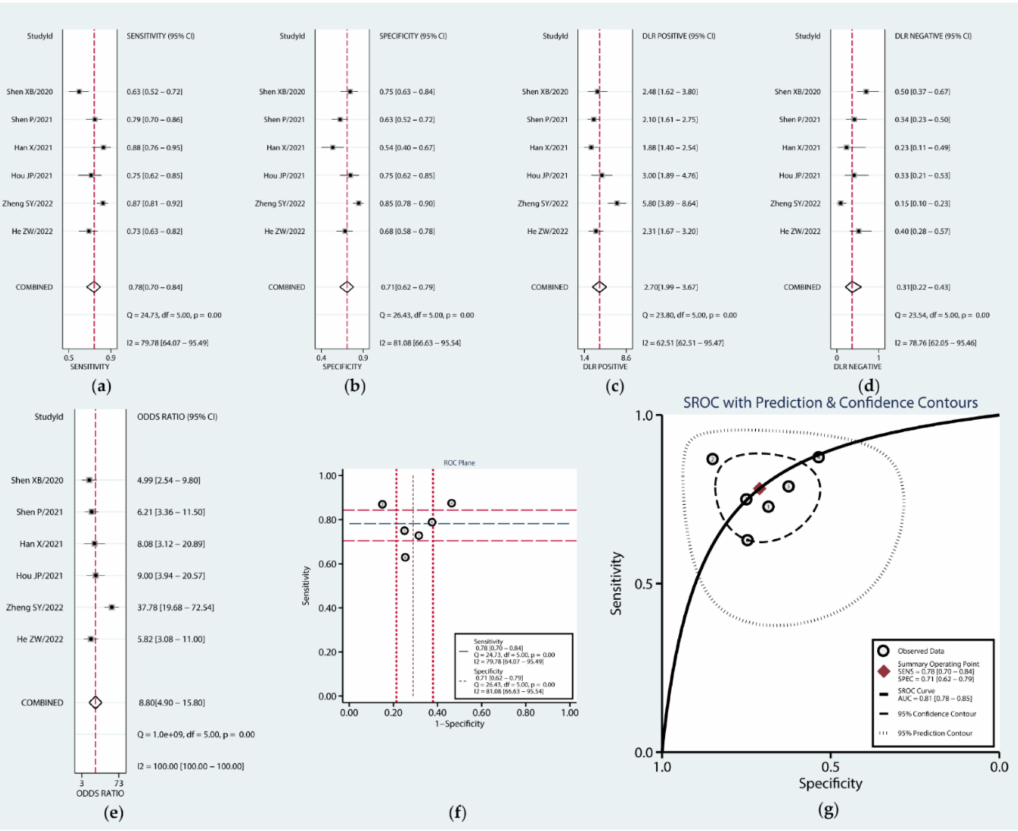
Figure 6. Forest plots of the sensitivity ( a ), specificity ( b ), PLR ( c ), NLR ( d ), DOR ( e ), ROC plane ( f ), and SROC curve ( g ) of combined circRNAs in pancreatic